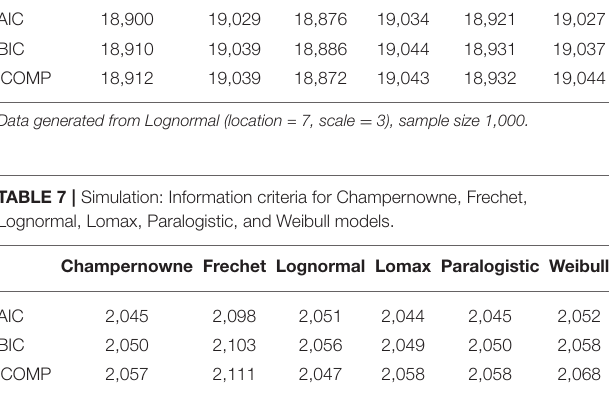
TABLE 1 | Simulation: Information criteria for Champernowne, Frechet, Lognormal, Lomax, Paralogistic, and Weibull models. Champernowne Frechet Lognormal Lomax Paralogistic Weibull